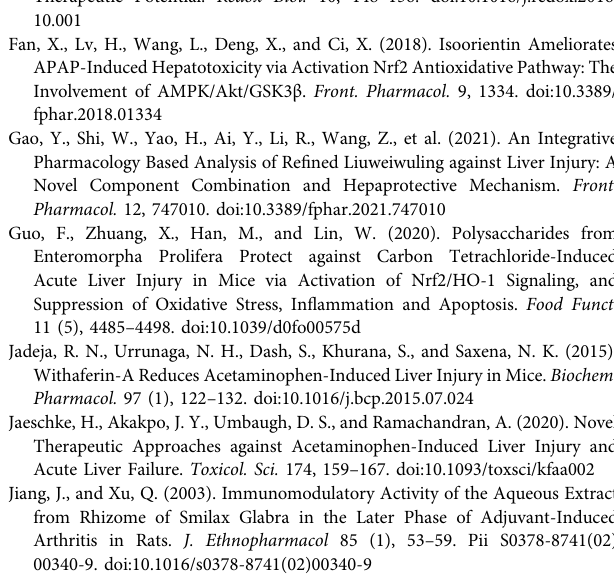
Supplementary Figure S2 | Effects of SCLP on Liver GSH. Data are presented as the mean ± S.D. ( n =4). 518 # p < 0.05 vs. NC. * p < 0.05 vs. APAP. Supplementary Figure S3 | The survival curve of experimental animals. SupplementaryFigureS4| EffectofSCLPonAML12cells (A) andHepG2 (B) cells viability. Data are 521 presented as the mean ± S.D. ( n =6). * p < 0.05, ** p < 0.01 Supplementary Figure S5 | EffectofSCLP on CYP2E1. Dataare presented as the mean ± S.D. ( n =3). # p 524 < 0.05 vs. NC. Supplementary Figure S6 | The original gel image of the western blot in animal experiment. (A) Nrf2, 526 (B) Nrf2 (cyto), (C) Nrf2 (nucl), (D) NQO-1, (E) GCLC, (F)